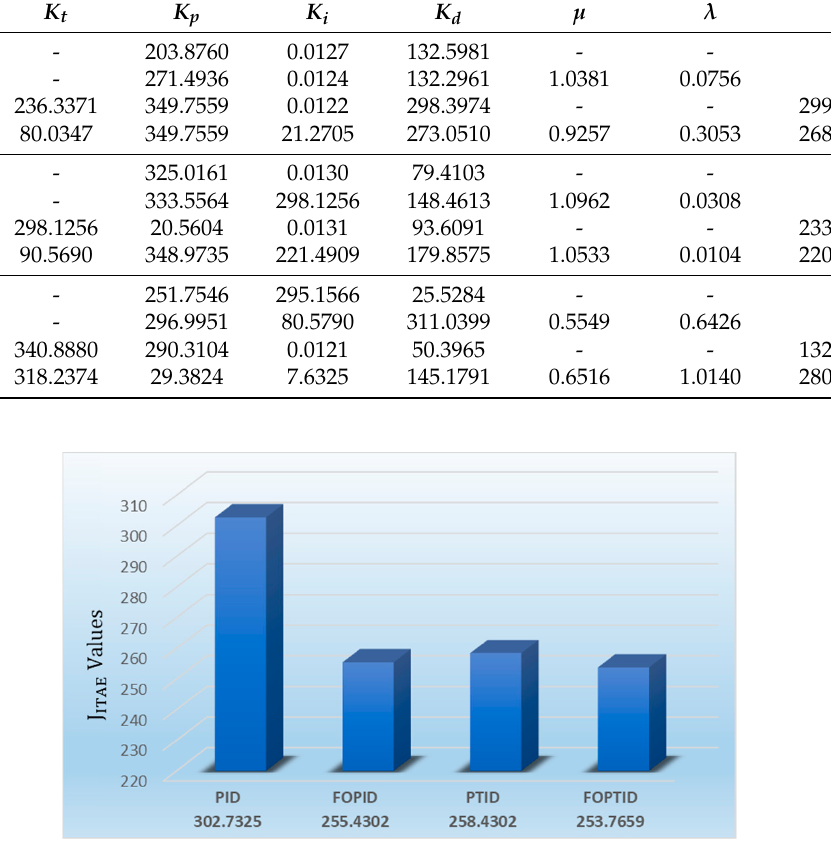
Figure 10. Comparison of 𝐽 (cid:3010)(cid:3021)(cid:3002)(cid:3006) values for PID, FOPID, PTID and FOPTID control strategies.